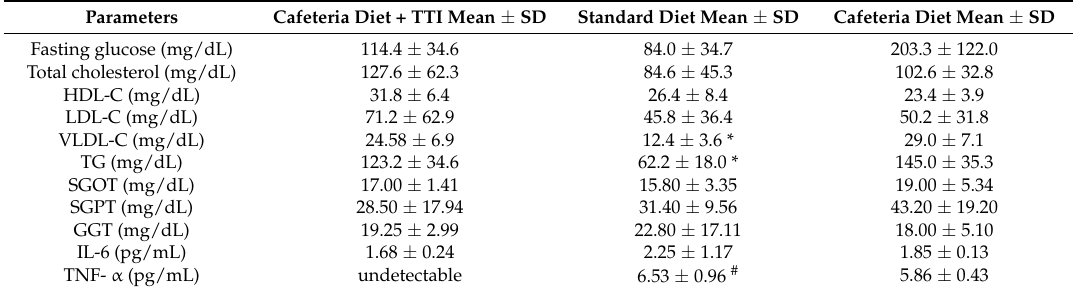
Table 4. Biochemical and inflammatory parameters in studied groups after 10 day of experiment. Parameters Cafeteria Diet + TTI Mean ± SD Standard Diet Mean ± SD Cafeteria Diet Mean ± SD Fasting glucose